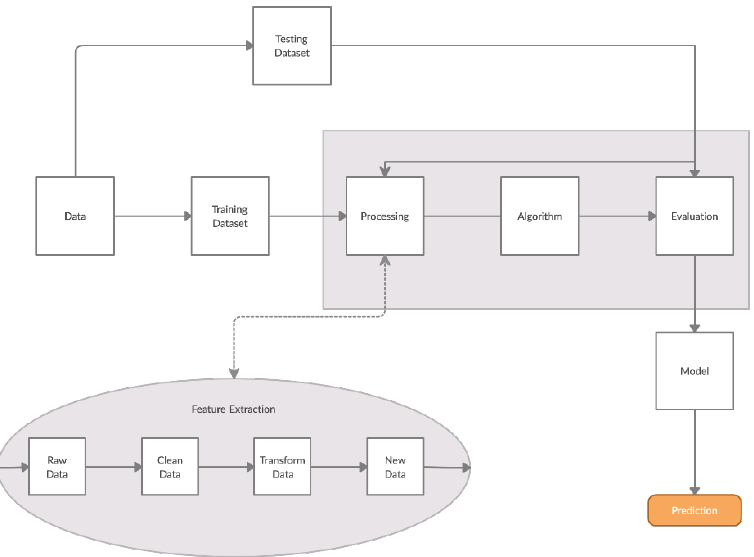
Figure 2. Bio Electric Diagnostics (B.EL.D) data analysis process on cloud functions. The analysis is being done in real time after the completion of the tests.